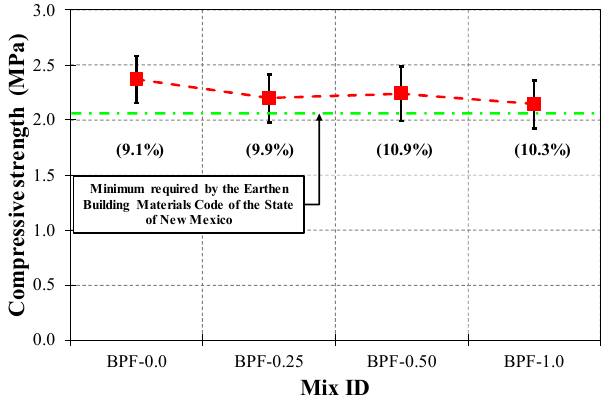
Figure 12. Compressive strength results for each earthen mix. Table 6. 5% significance level ANOVA tests for the compressive strength of earthen mixes at 28 days.